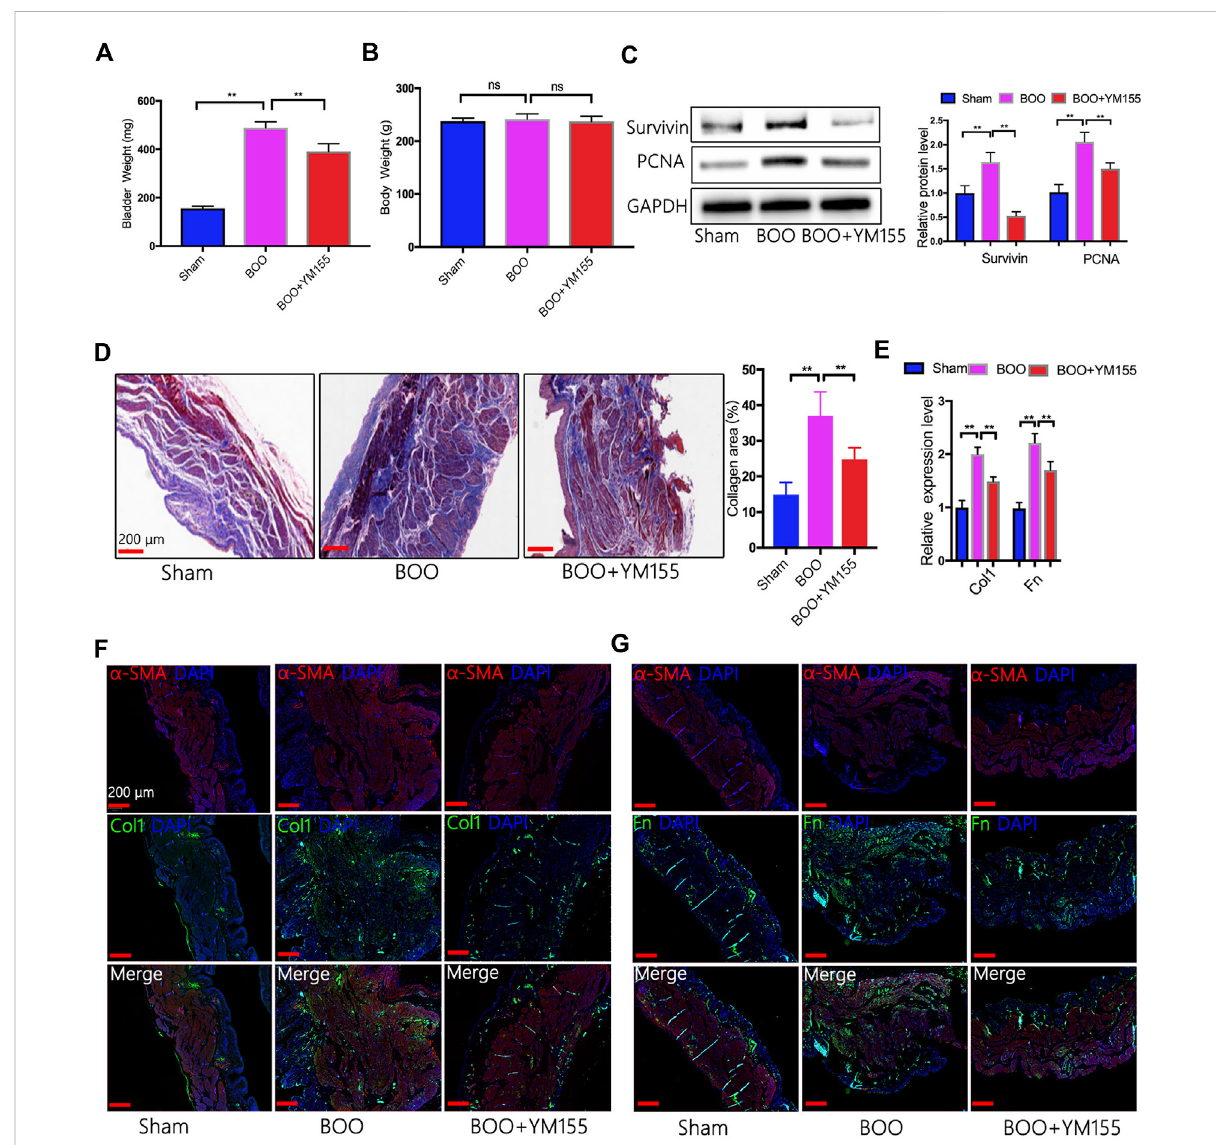
FIGURE 2 TheeffectofYM155 onbladderhistologyalterationsecondarytoBOO. (A) Thealterationofbladderweights. (B) Thealterationofbodyweights. (C) The protein level of survivin and PCNA in the bladder wall. (D) Masson ’ s trichrome staining of the bladder wall and percent collagen area of the bladder wall. (E) The relative expression of Col1 and Fn was obtained by measuring the densities of fl uorescence. (F) Coimmunostaining of Col1 (green)and α -SMA(red)inbladderwall. (G) CoimmunostainingofFn(green)and α -SMA(red)inthebladderwall.Thestainingimagesweretaken under the original magni fi cation ×100. Data are presented as the mean ± SD, n = 8. ** p < 0.01; * p < 0.05 ; (ANOVA). Scale bar: 200 μ m.